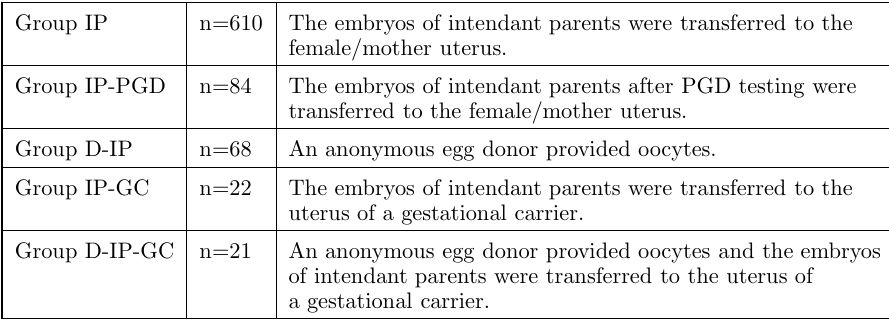
Table 1. Different types of cycles in infertility treatment Group IP n=610 The embryos of intendant parents were transferred to the female/mother uterus. Group IP-PGD n=84 The embryos of intendant parents after PGD testing were transferred to the female/mother uterus. Group D-IP n=68 An anonymous egg donor provided oocytes. Group IP-GC n=22 The embryos of intendant parents were transferred to the uterus of a gestational carrier. Group D-IP-GC n=21